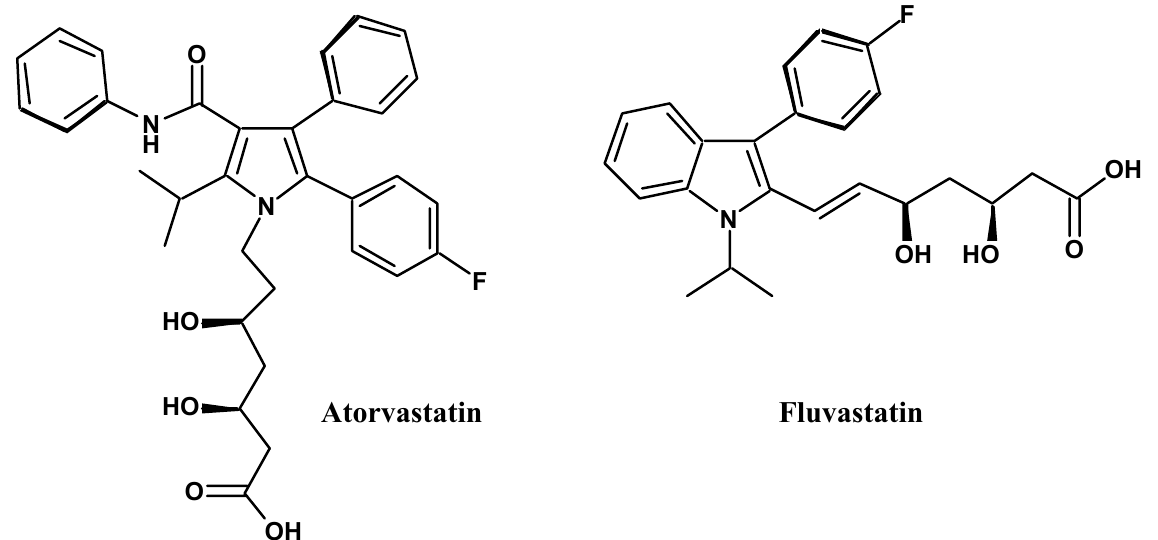
Figure 1. Structures of the clinically used pyrrole-containing hypolipidemic agents atorvastatin (Lipitor R ) and fluvastatin (Lescol R ).